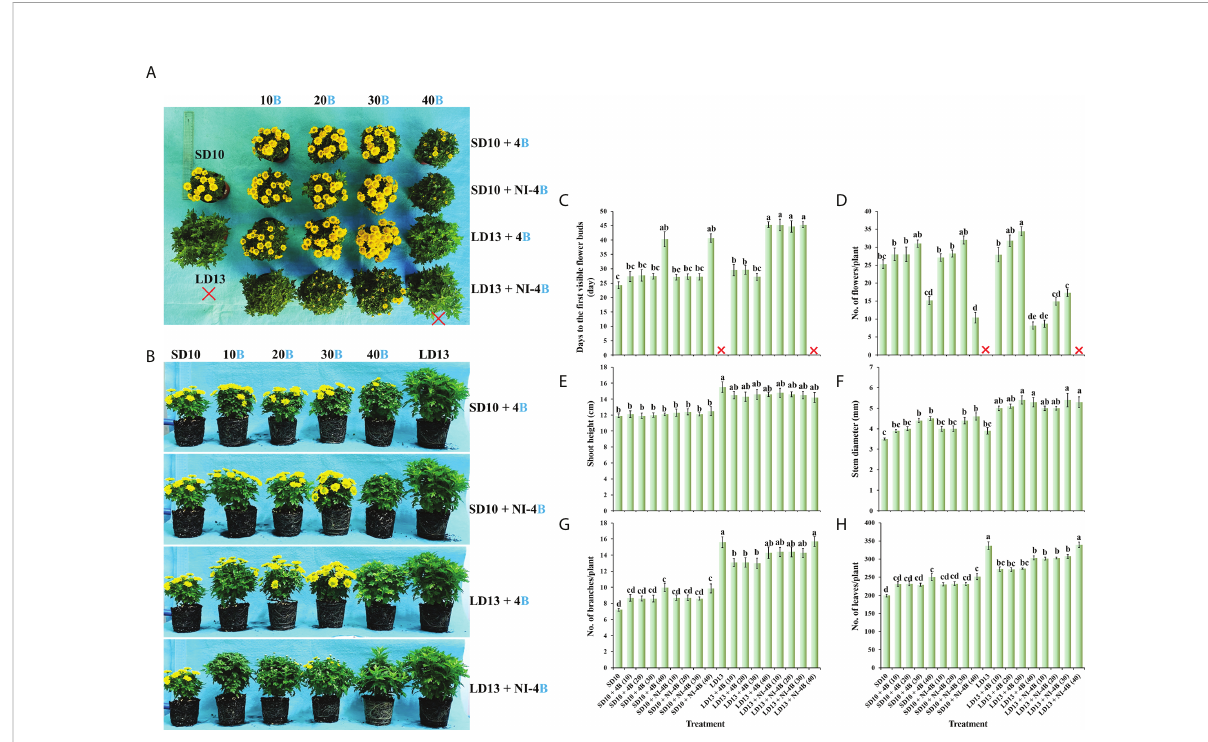
FIGURE 2 The fl owering and morphology of chrysanthemum ‘ Gaya Glory ’ under different intensities of supplemental or night-interruptional blue light, after 60 days of exposure to the photoperiodic light treatments: the top view (A) , side view (B) , the days to the fi rst visible fl ower buds (C) , the number of fl owers per plant (D) , shoot height (E) , stem diameter (F) , the number of branches per plant (G) , and the number of leaves per plant (H) . The red cross, the non- fl owered treatment. Vertical bars indicate the means ± standard error (n = 6). Different lowercase letters indicate signi fi cant separation within treatments by Duncan ’ s multiple range test at p ≤ 0.05. See Figure 1 for details of photoperiodic light treatments with blue